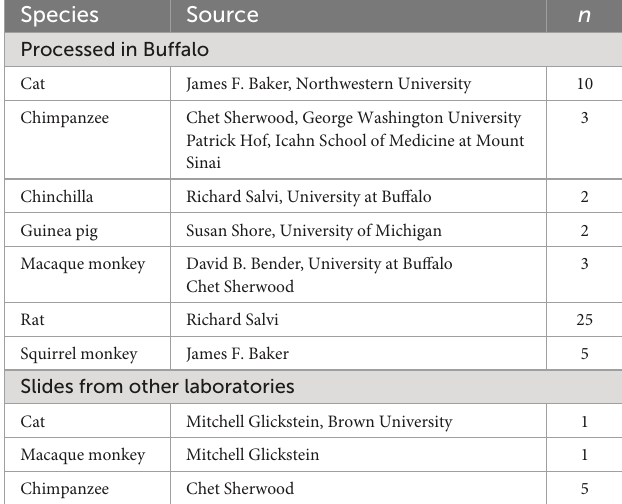
TABLE 3 Primary antibodies and dilutions. Antigen Manufacturer, Cat. #